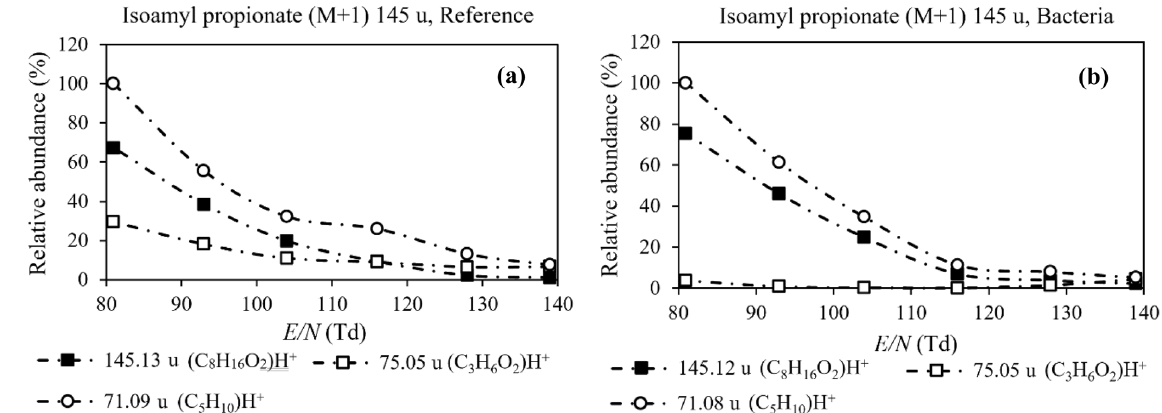
Figure 4. ( a , b ) Relative abundances of the PTR-MS signals (M + 1) for the protonated molecular ion and the most important fragments of isoamyl propionate. Additional diagrams with elemental compositions and accurate masses can be found as Supplementary Data of this article. Signals are normalized to the most abundant signal (100%) in any of the different E/N